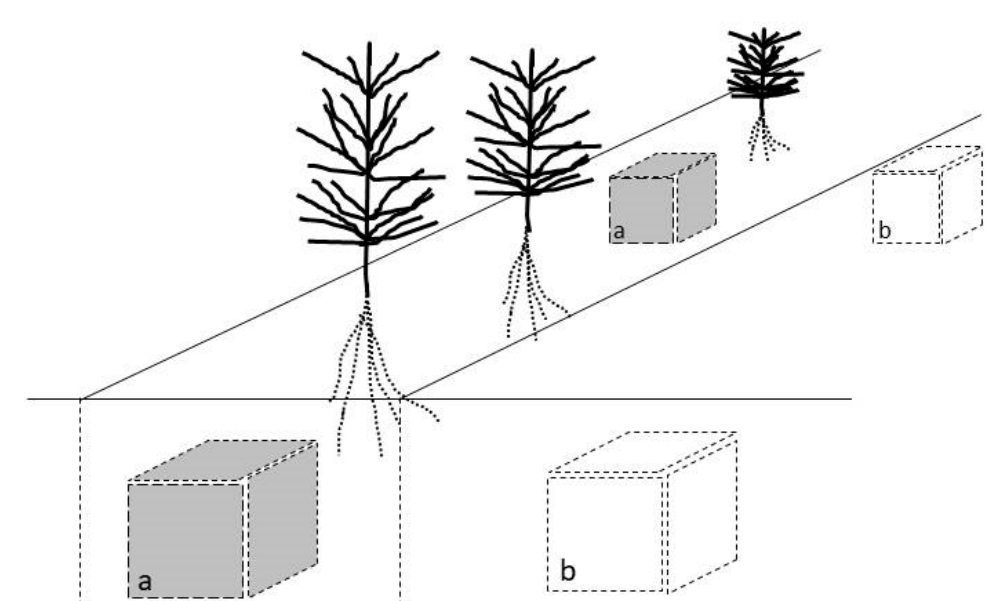
Figure 2. Location of small pits with sawdust ( a ) between seedlings in the row, and control pit without sawdust ( b ) in the interrow.